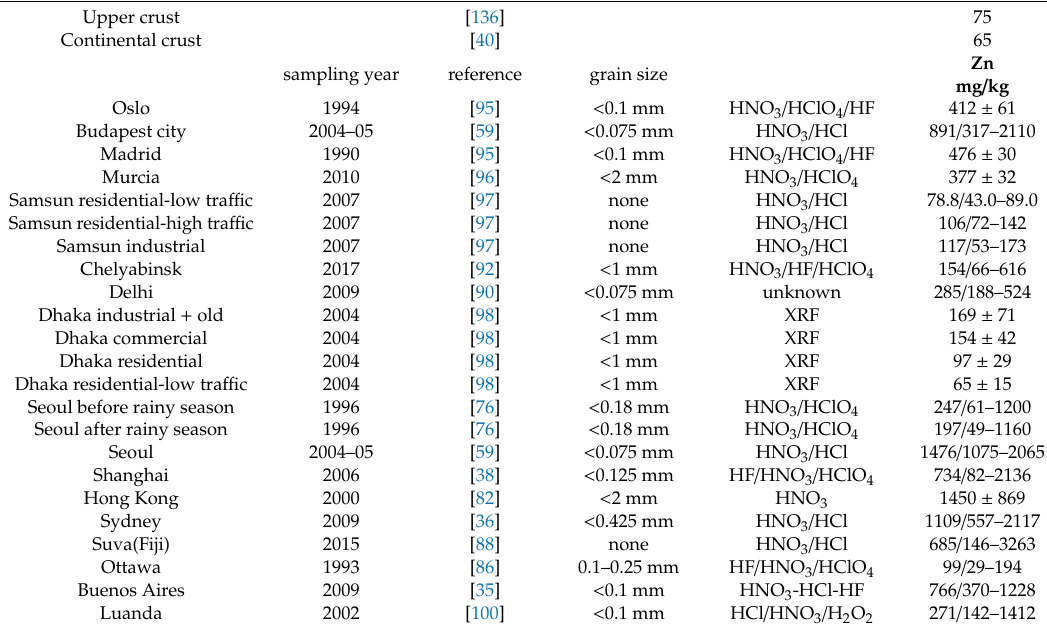
Table A39. Zinc in road